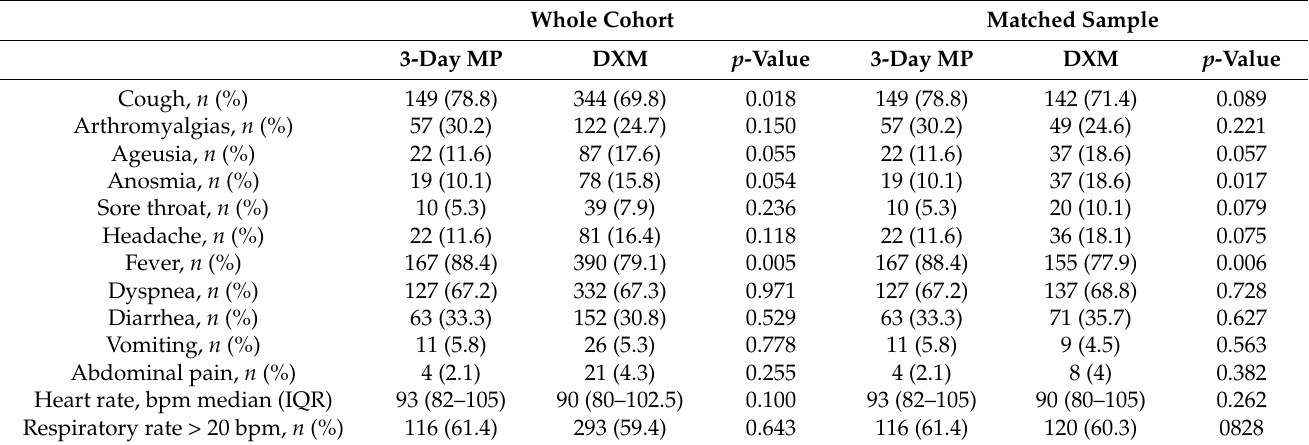
Table 2. Comparison of symptoms and signs upon admission between